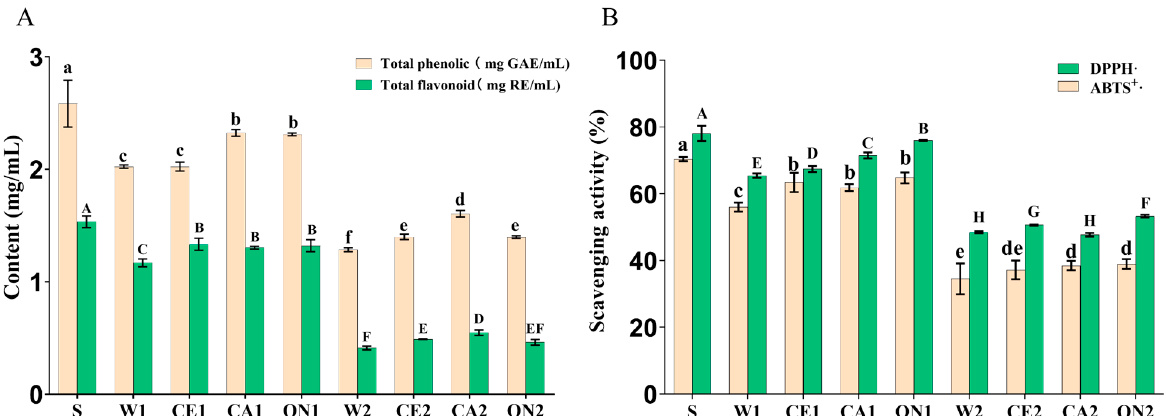
Figure 1. Total phenolics, flavonoids ( A ), and antioxidant capacity ( B ) of soy sauce. Different letters represent significant differences between groups ( p < 0.05).